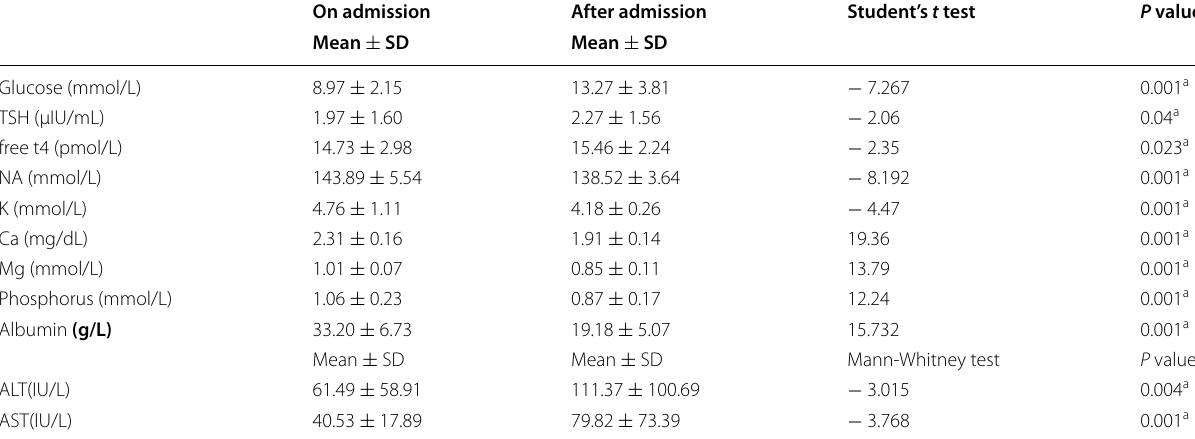
Table 2 Endocrine parameters, electrolytes, and liver functions before and after admission